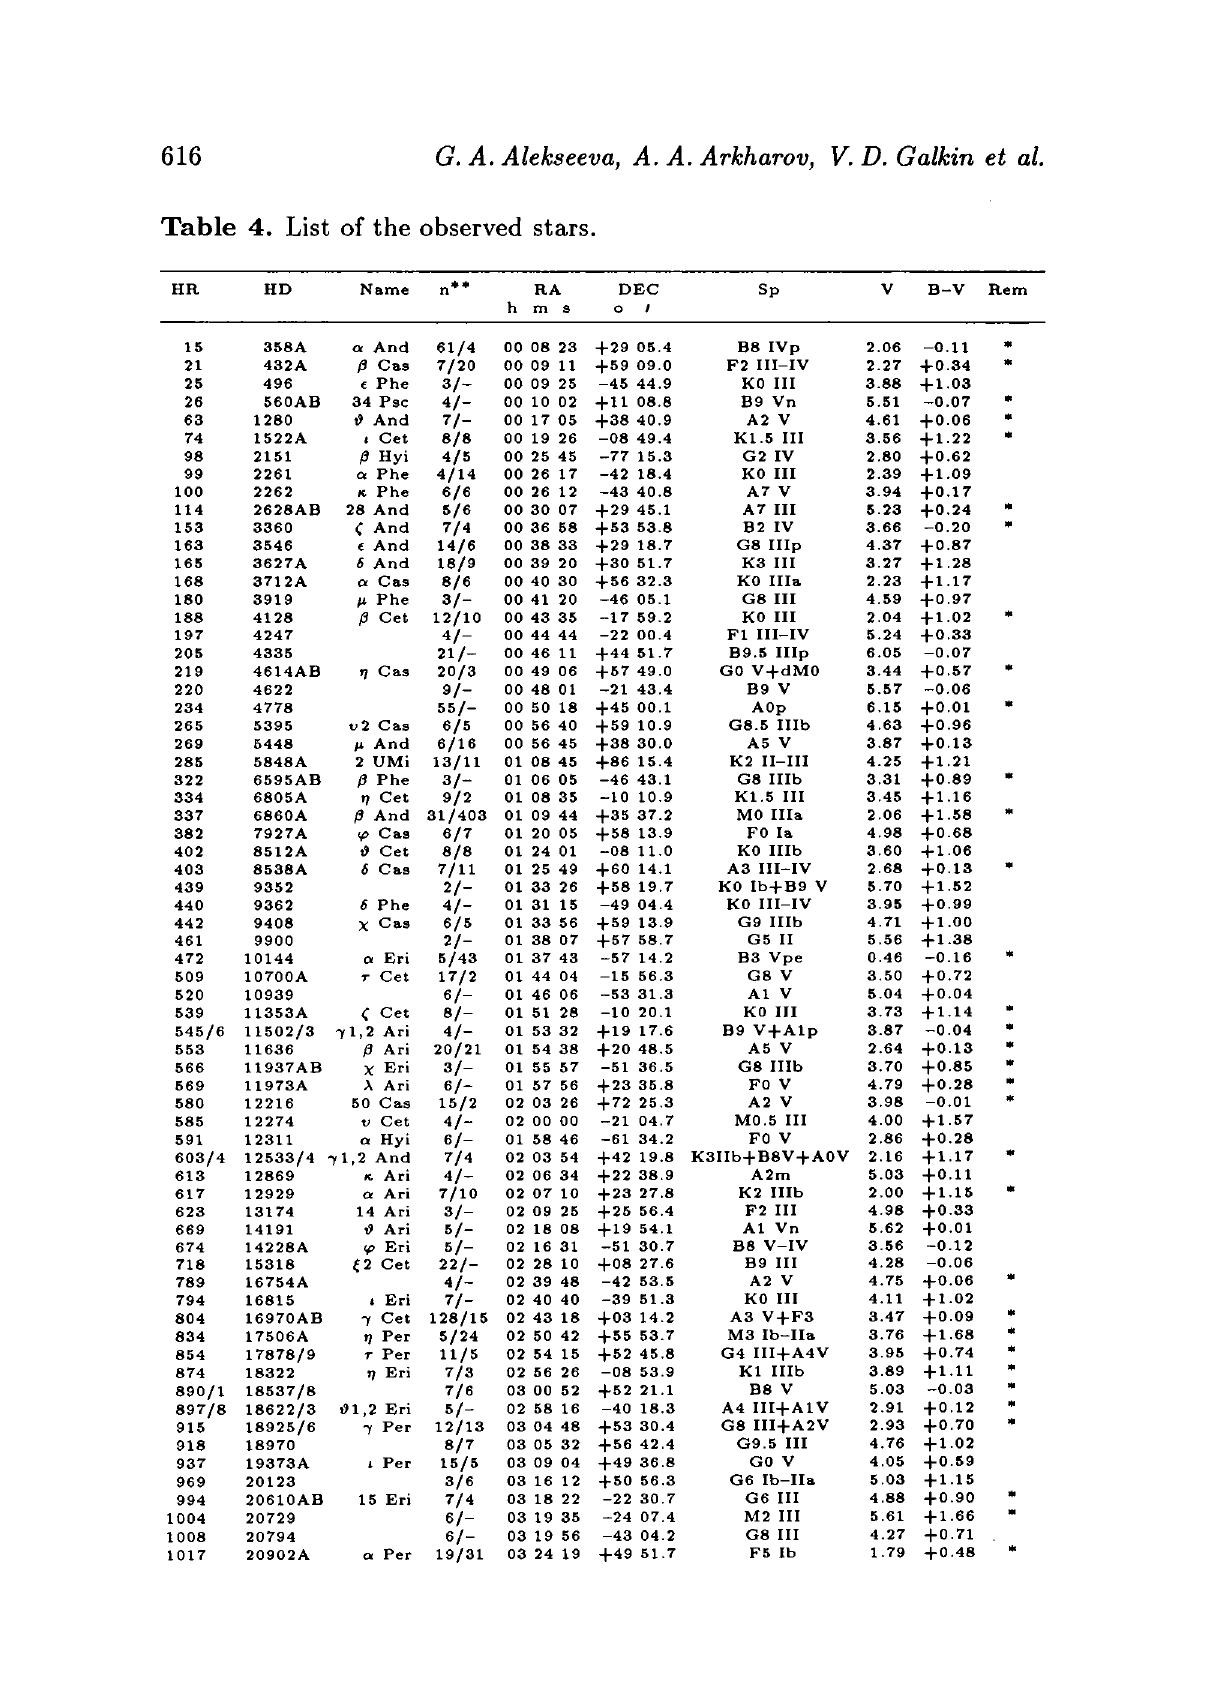
Table 4. List of the observed